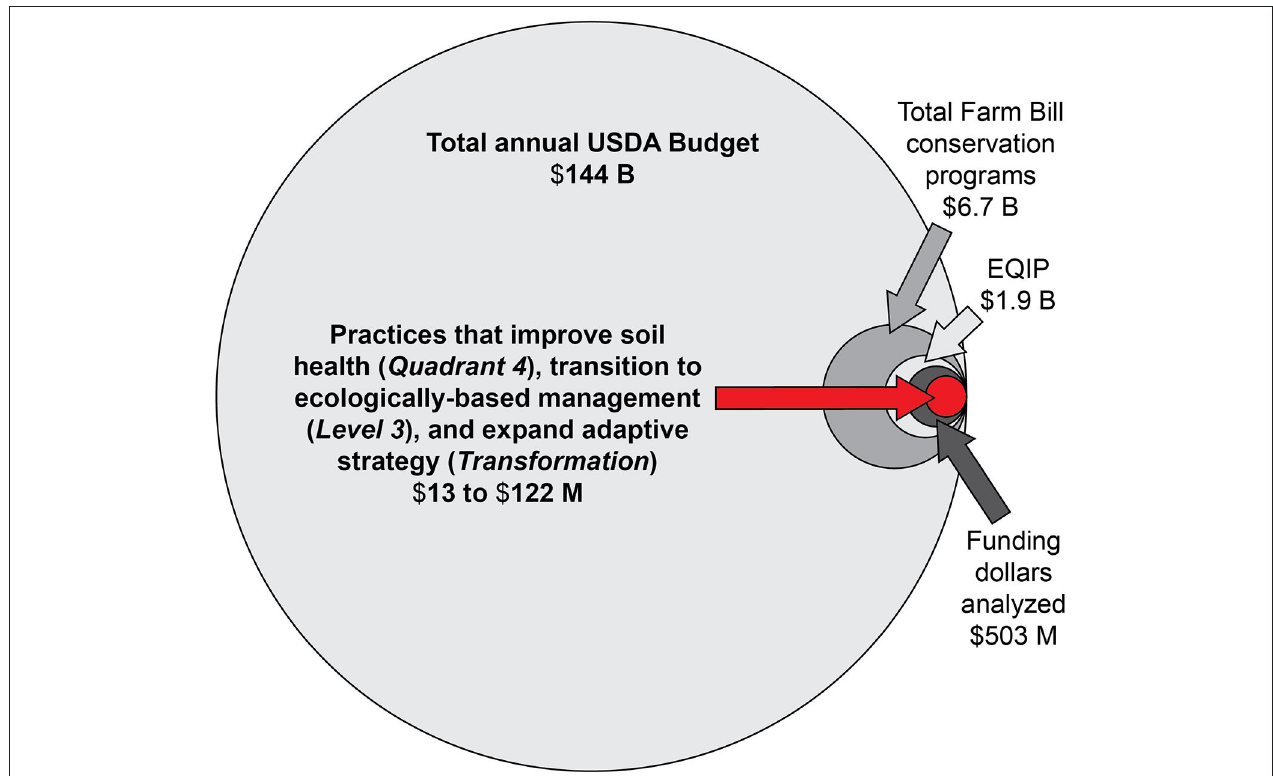
FIGURE 2 | Summary of funding dollars analyzed in this research. We found that investments in conservation practices that improve soil health, transition to ecologically-based management and expand adaptive strategy within EQIP comprise between 13 and 122 million dollars, which represents less than one-tenth of 1% of the U.S. Department of Agriculture’s annual budget which was 144 billion in 2018 (USDA,